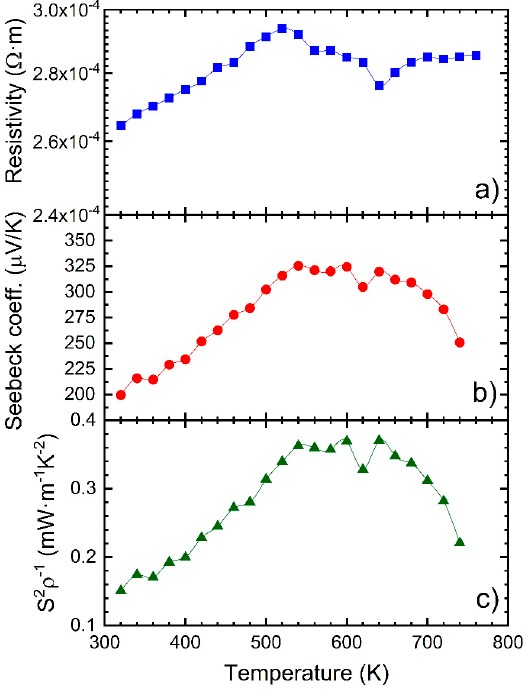
Figure 4. ( a ) Resistivity, ( b ) Seebeck coefficient and ( c ) power factor of the arc-melted AgSbTe 2 . The power factor is calculated from the experimental resistivity and the Seebeck coefficient.